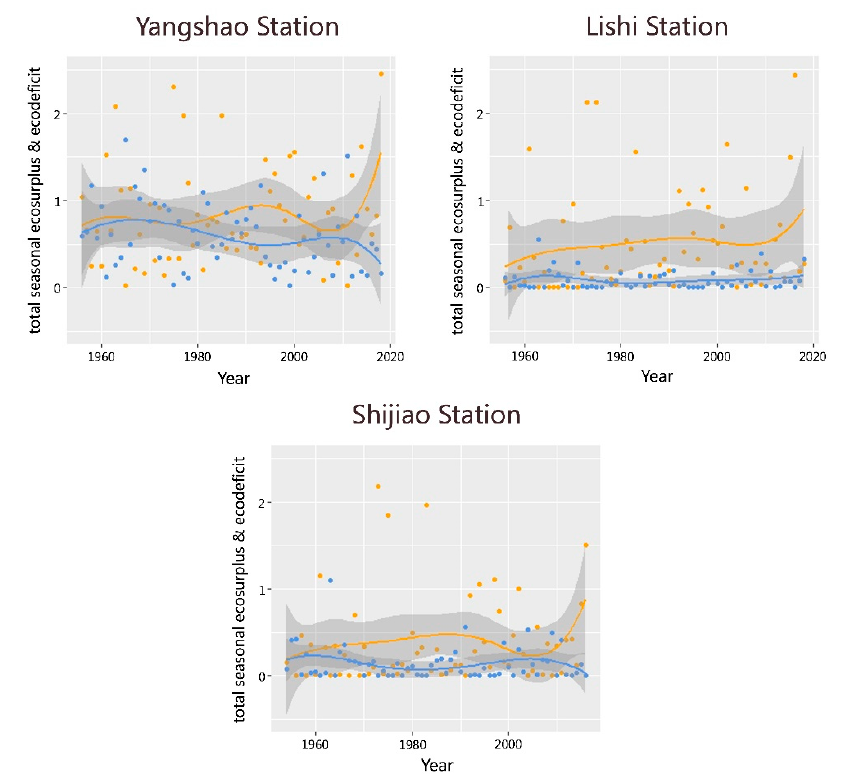
Figure 5. Yearly variations of the total seasonal ecosurplus and ecodeficit. The solid curves denote the fitting curves and the gray shaded parts are the 95% confidence intervals.